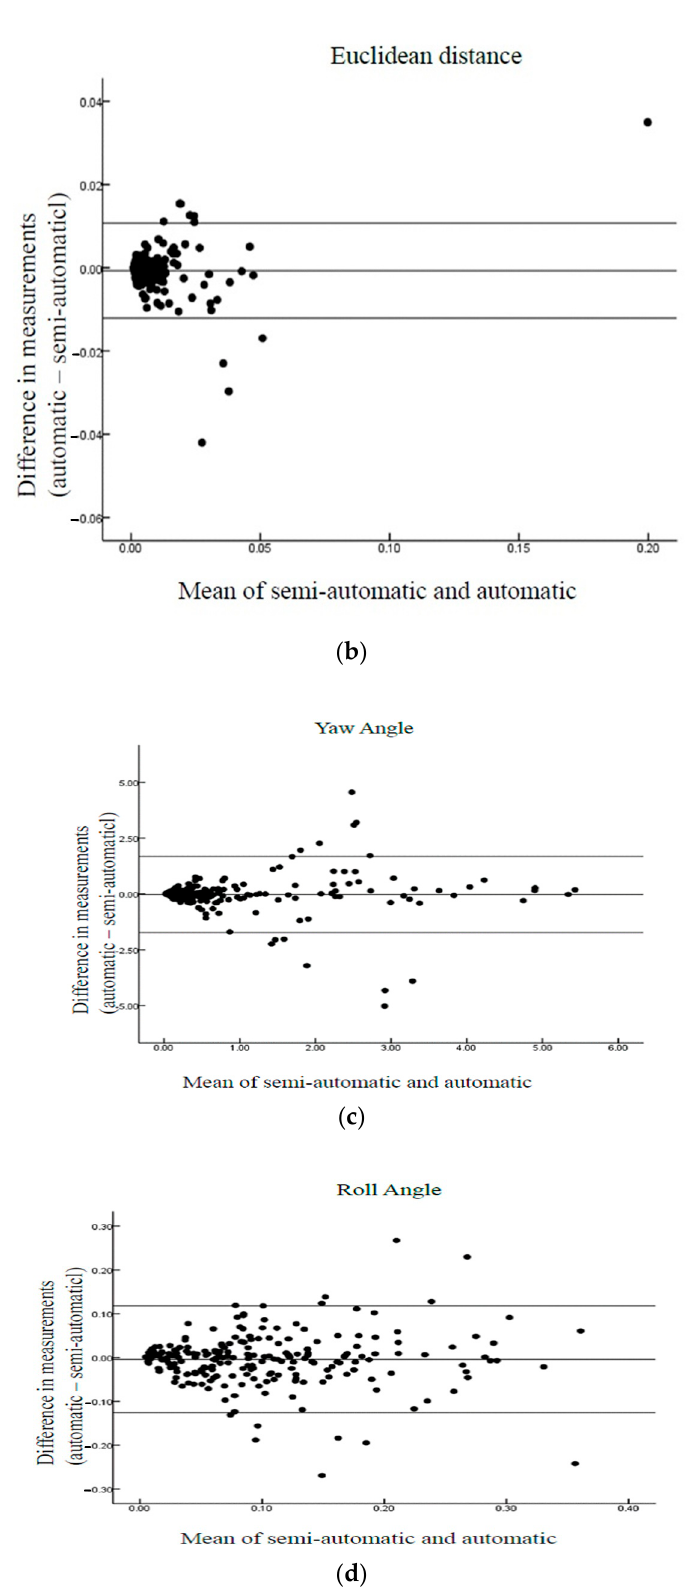
Figure 12. Bland–Altman plots of the differences between automatic/semi-automatic and manual methods of fetal MSP detection: ( a ) included angle, ( b ) Euclidean distance, ( c ) yaw angle, and ( d ) roll angle. The lines indicate the mean bias and 95% limits of agreement.